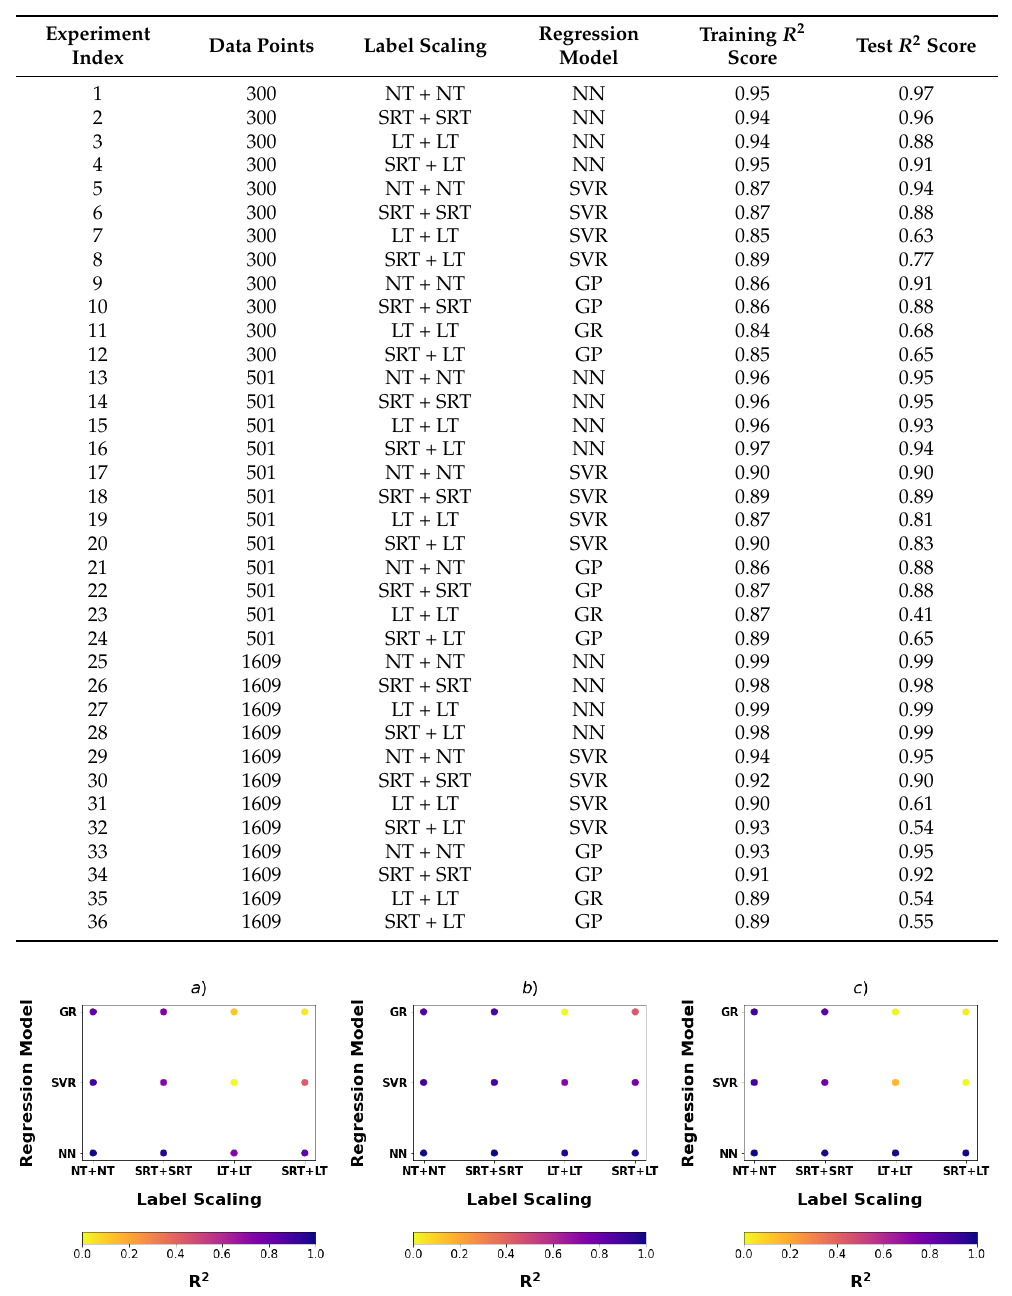
Figure 6. Visualization of R 2 to Model and label. ( a ) Model: 300 data points. ( b ) Model: 501 data points. ( c ) Model: 1609 data